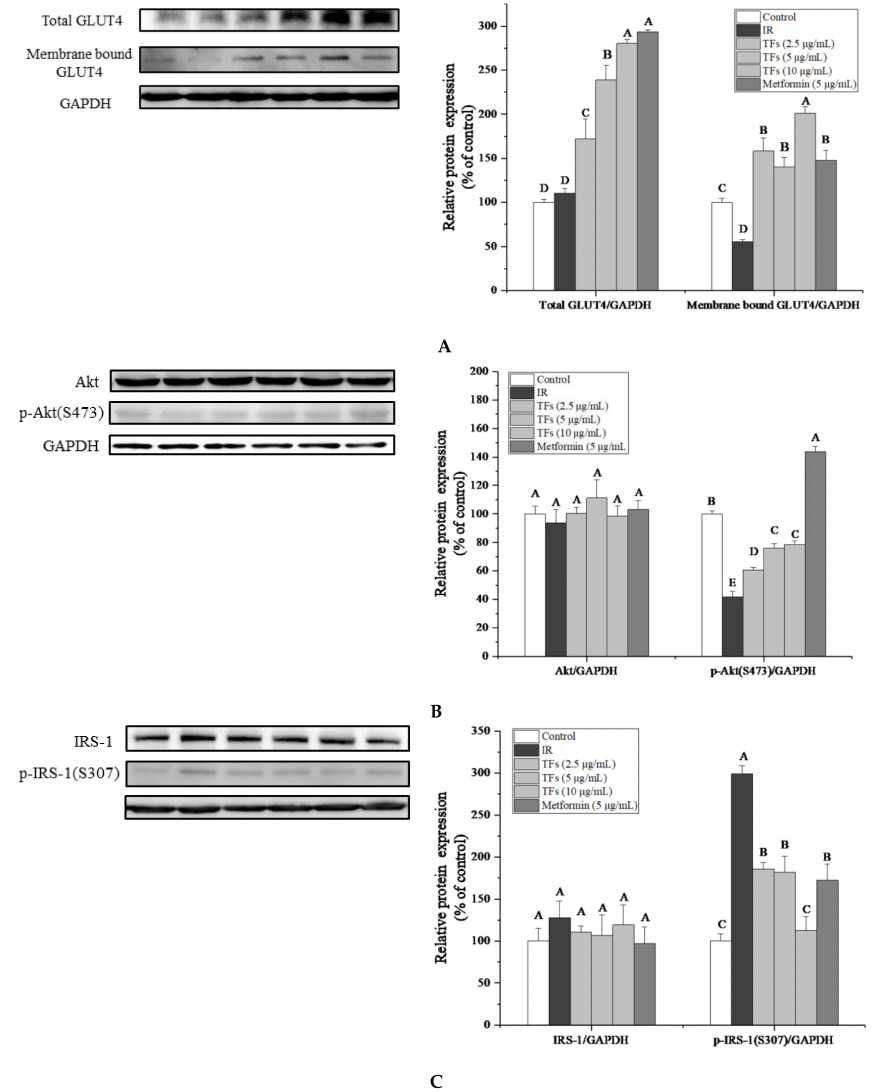
Figure 5. Effects of theaflavins (TFs, 2.5–10 µ g/mL) on insulin signaling pathway in insulin-resistant HepG2 cells induced by PA after 24h treatment. ( A ) Protein expression of total GLUT4 and membrane bound GLUT4. ( B ) Protein expressions of Akt and phosphor-Akt (Ser473). ( C ) Protein expressions of IRS-1 and phosphor-IRS-1 (Ser307). The protein levels were determined by western blot assay